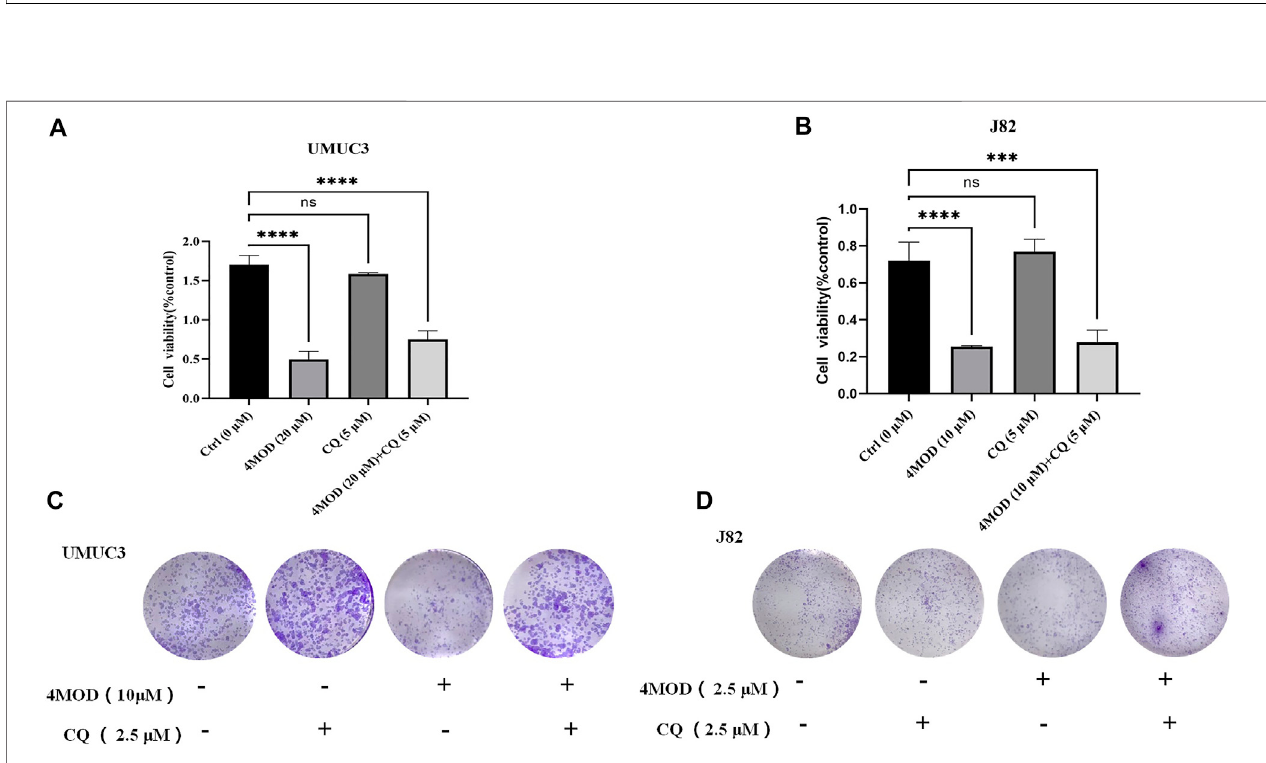
FIGURE 4 | 4MOD induces autophagy in BC cells (A) The human BC cell lines UMUC3 and J82 were treated with 4MOD (20 μ M) for 12 h. The relative mRNA expression of LC3 was measured by RT-PCR (B) The UMUC3 and J82 cells were treated with an increasing concentration of 4MOD for 72 h. The expression of LC3-II, LC3-I, Beclin-1, and β -actin was measured by Western blot analysis in the cells (C – D) The results of Western blot analysis were quanti fi ed by ImageJ software. Data are presented as mean ± SD. Statistic signi fi cant differences were indicated: * p < 0.05, ** p < 0.01.